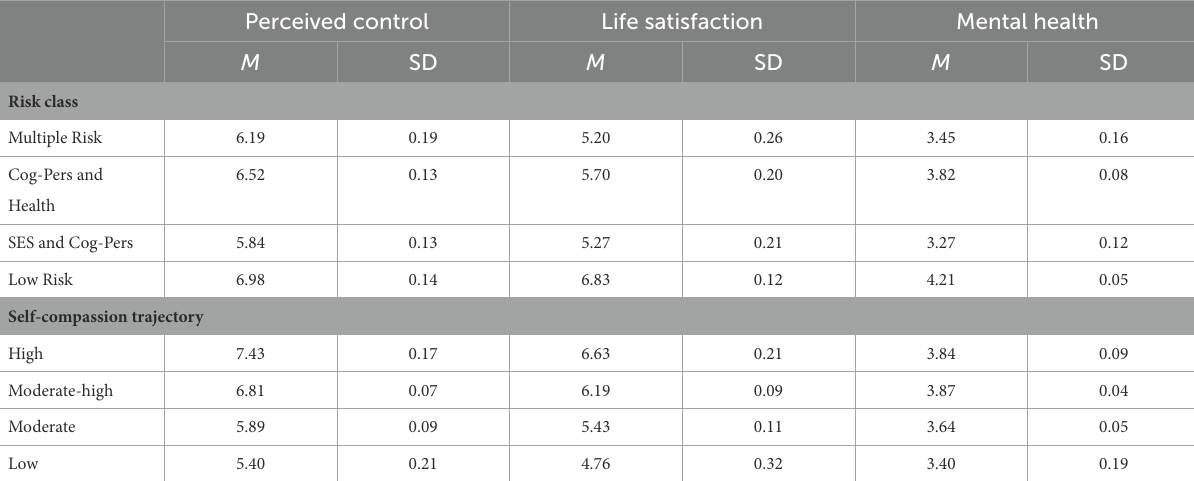
TABLE 8 Means of outcome variables corresponding to main effects.